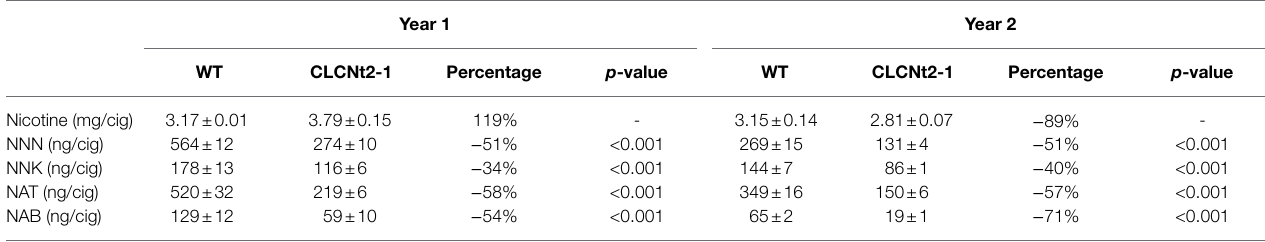
TABLE 2 | Nicotine, NNN, NNK, NAT, and NAB content in the mainstream smoke of cigarettes made from the lamina of WT and CLC-RNAi line CLC2-1 leaves.